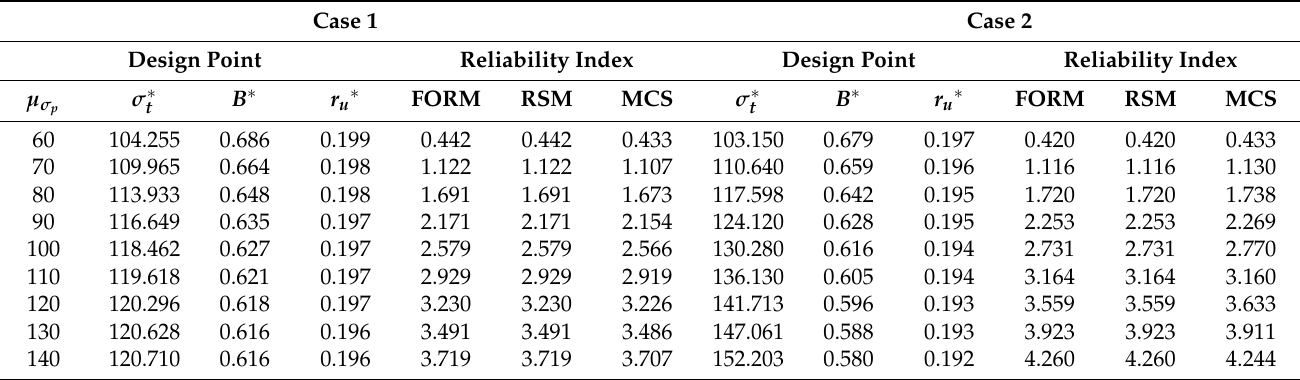
Figure 2. Comparisons of the probability distribution functions of normal and lognormal distribution for different variables. Table 2. Design points and reliability indexes versus different support